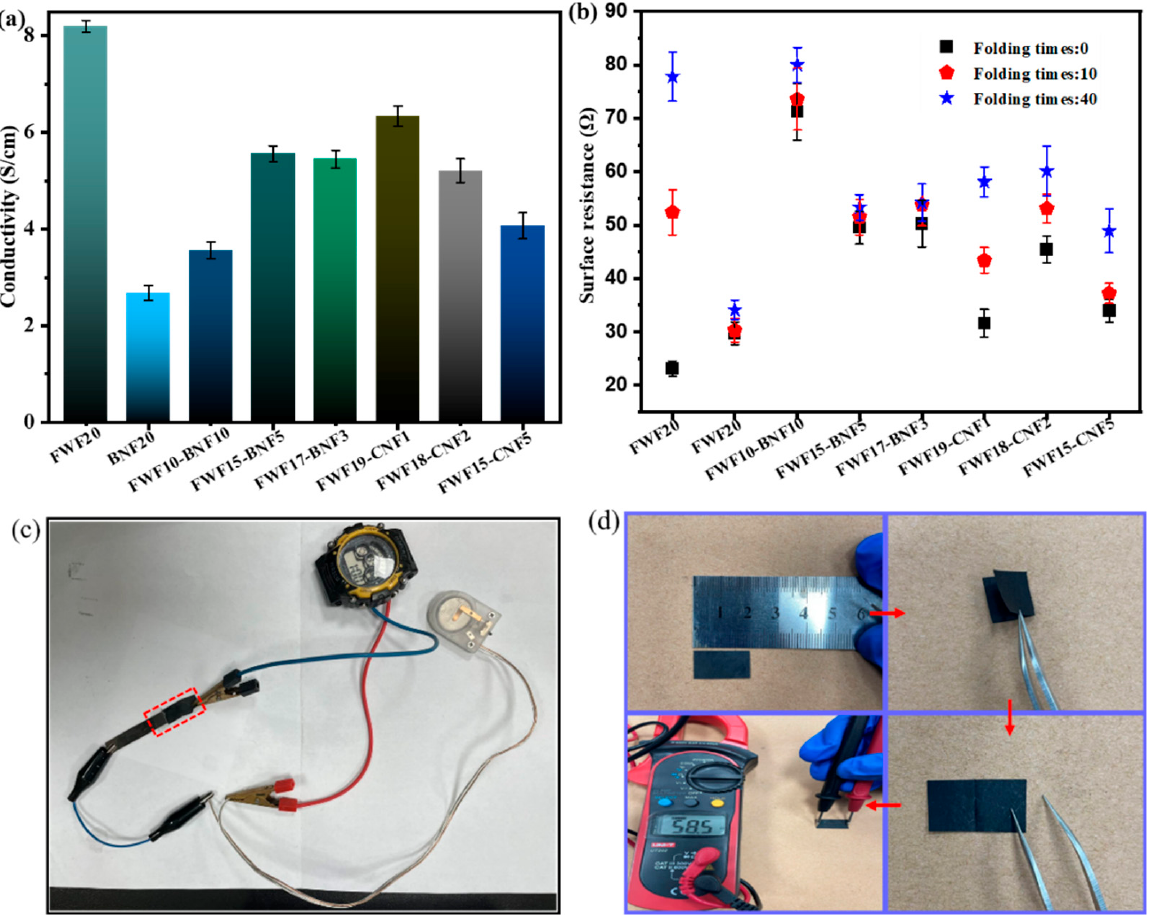
Figure 5. Physical properties of paper-based electrodes: ( a ) Electrical conductivity; ( b ) Surface resistance at different folding times; ( c ) Photograph of the watch powered by the battery assembled by FWF15-BNF5 and the conductive path connected by FWF15-BNF5; ( d ) Photograph of the paper-based electrode folding resistance test.